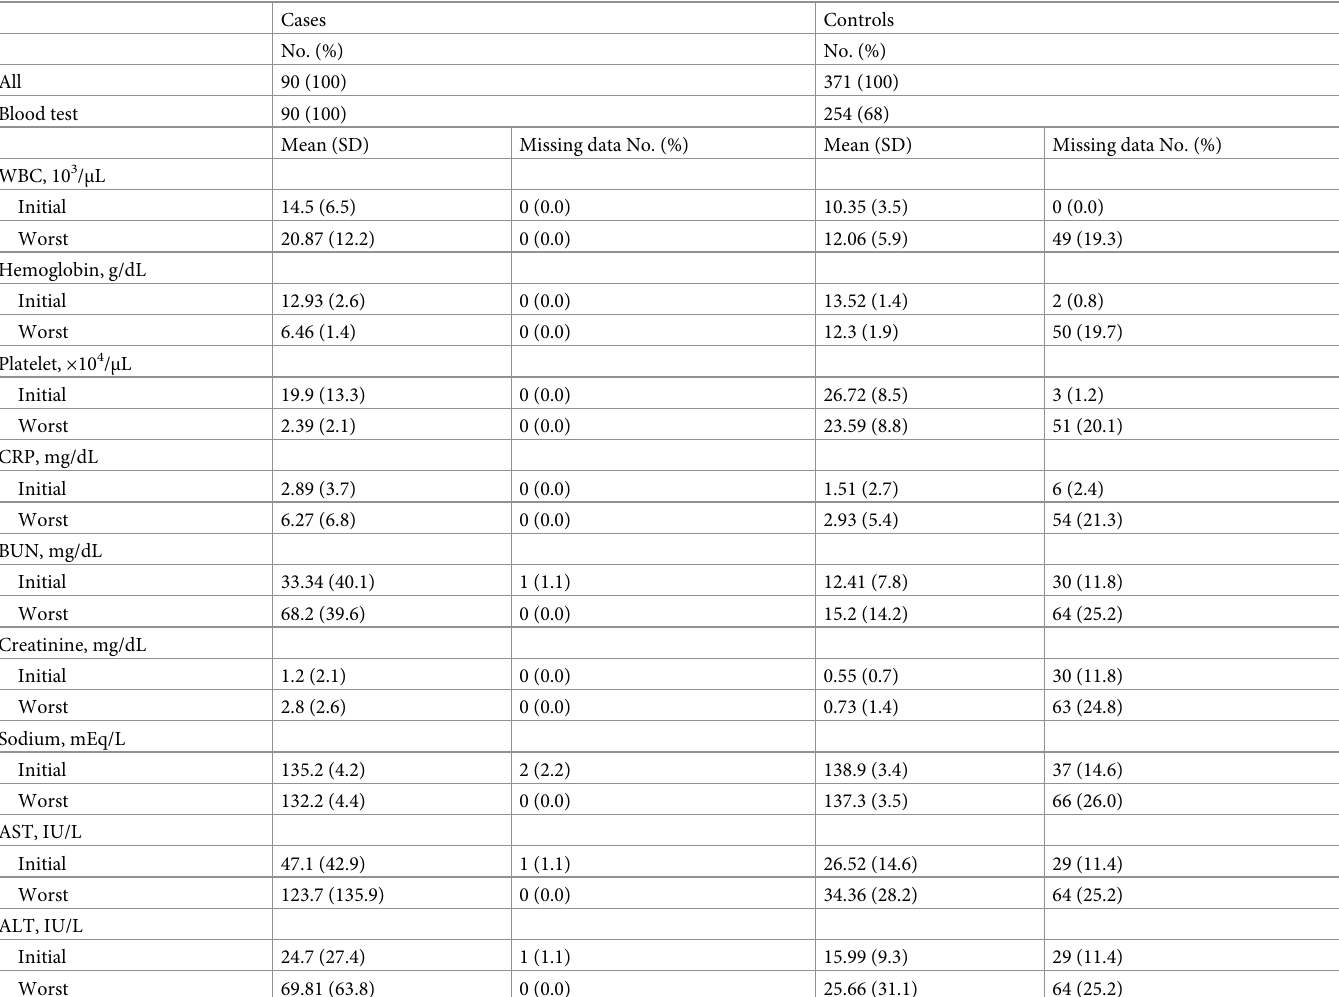
Table 3. Laboratory data of the cases and